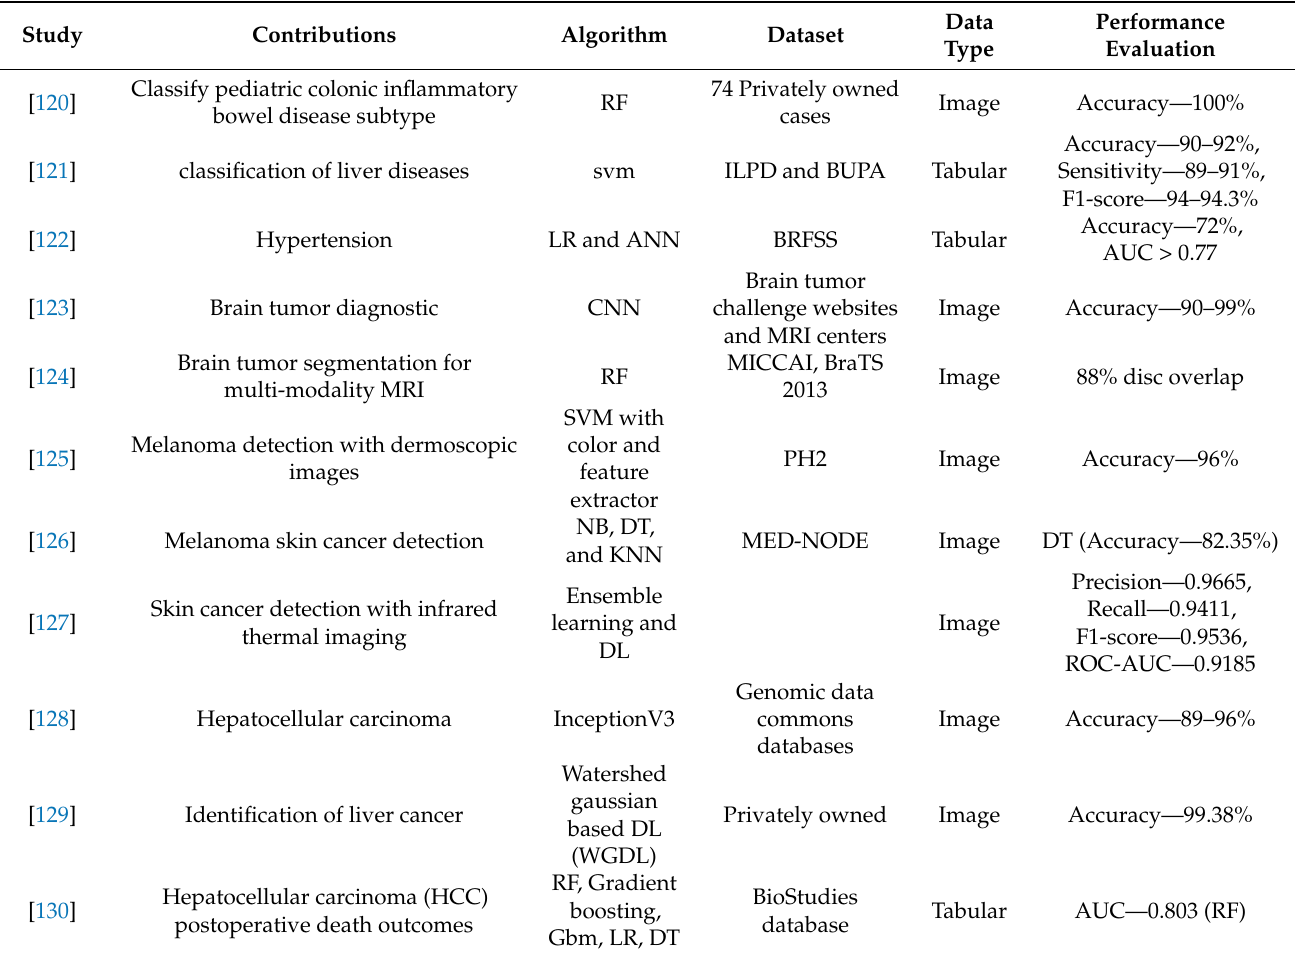
Table 10. Referenced literature that considered Machine Learning on various disease